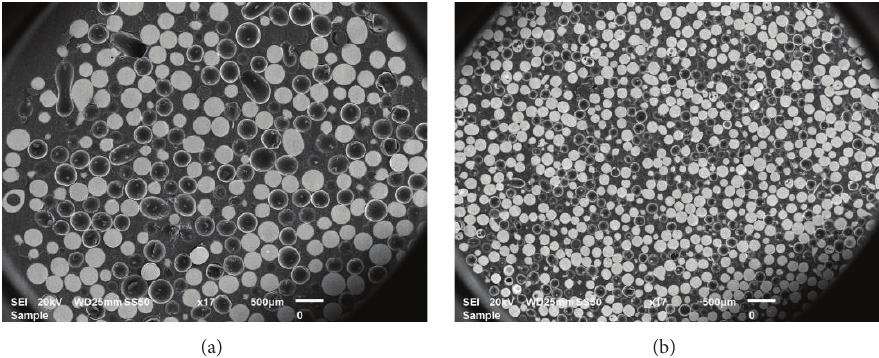
Figure 3: Particles loaded to the quartz mold: (a) coarse particles in sample A and (b) fine particles in sample D.